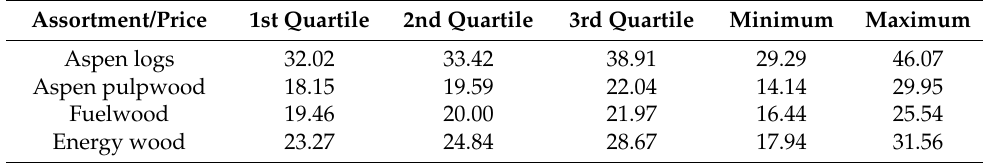
Figure 2. Price dynamics of aspen wood assortments in Estonia (from January 2012 to December 2020), which was used as an input for different price scenarios analysed in this study (Table 4). Table 4. Prices of assortments for different price scenarios applied in this study (EUR m − 3